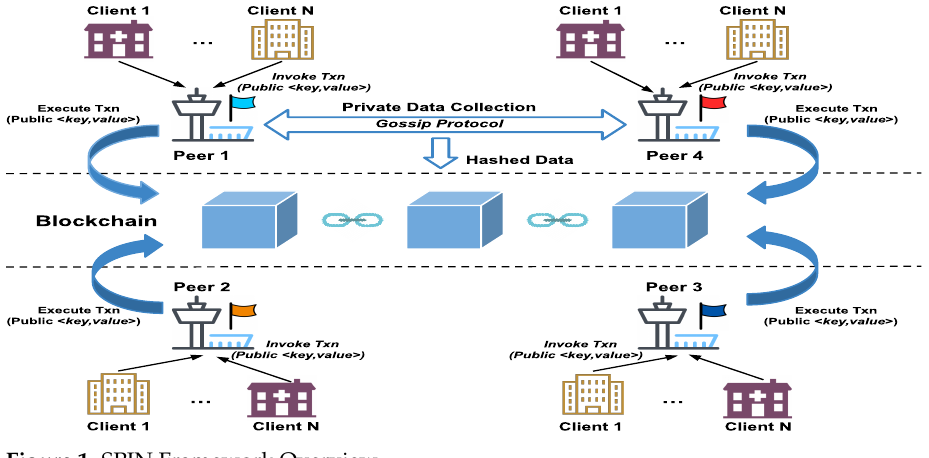
Figure 1. SPIN Framework